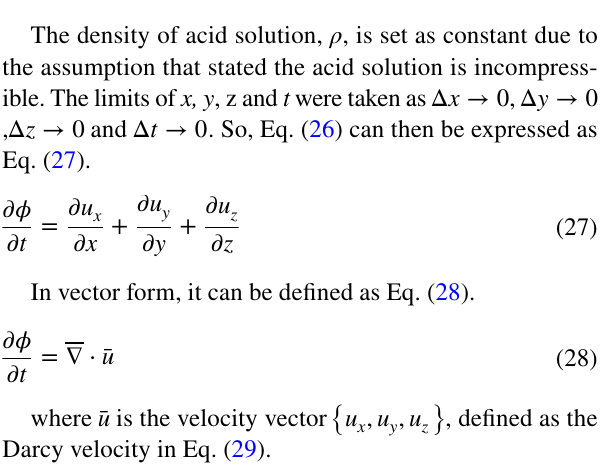
The mass of acid solution flowing into the control volume is described in Eq. (22).